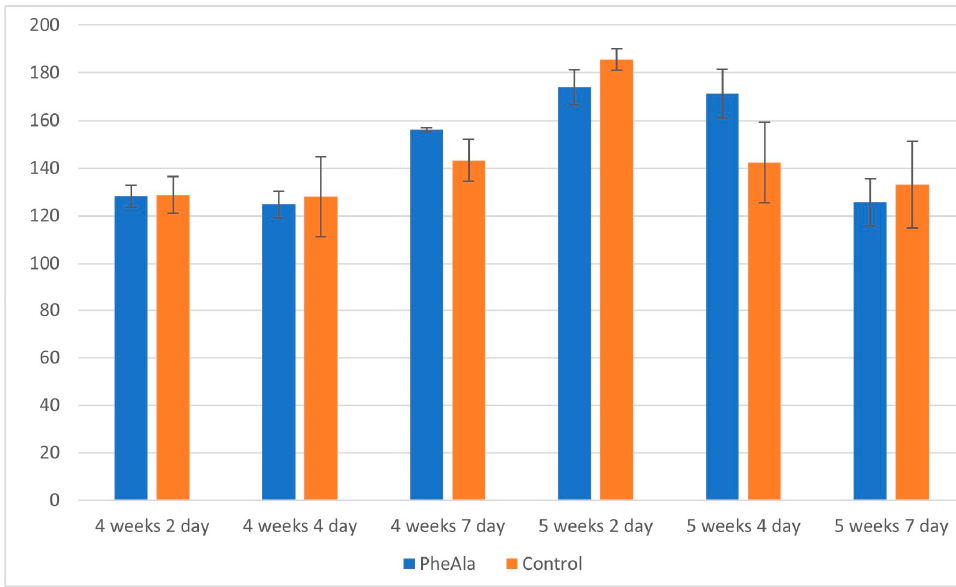
Figure 3. Total content of alkaloids in the biomass of R. graveolens agitated shoot cultures (4- and 5-week growth cycle, time after addition of phenylalanine [PheAla]: 2, 4, and 7 days).